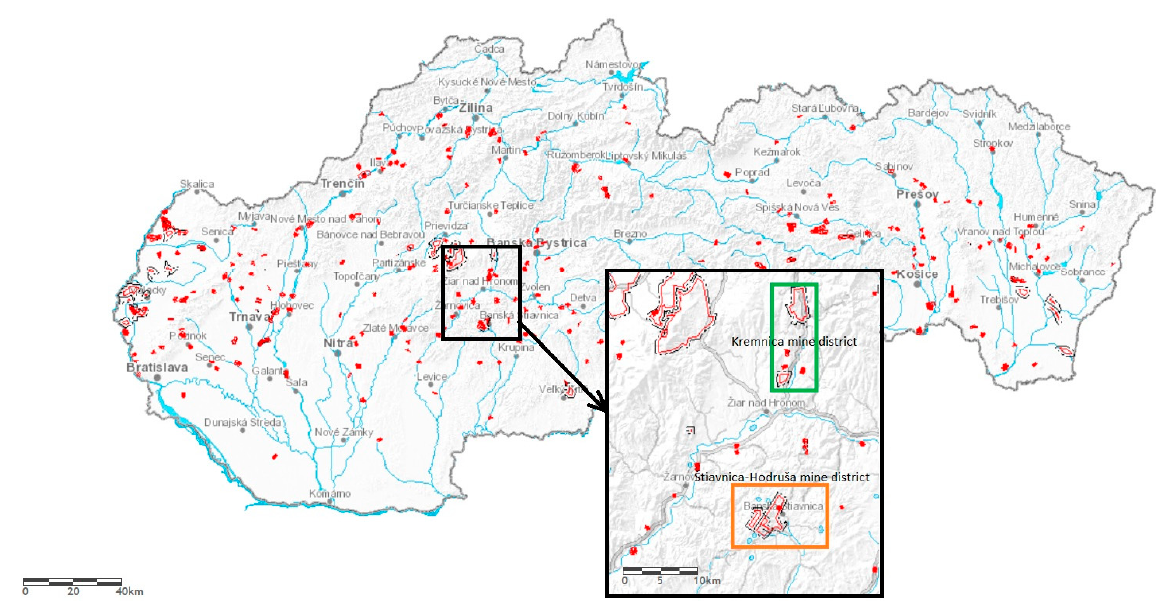
Figure 1. The localization of Kremnica and Hodruša-Štiavnica mine districts.